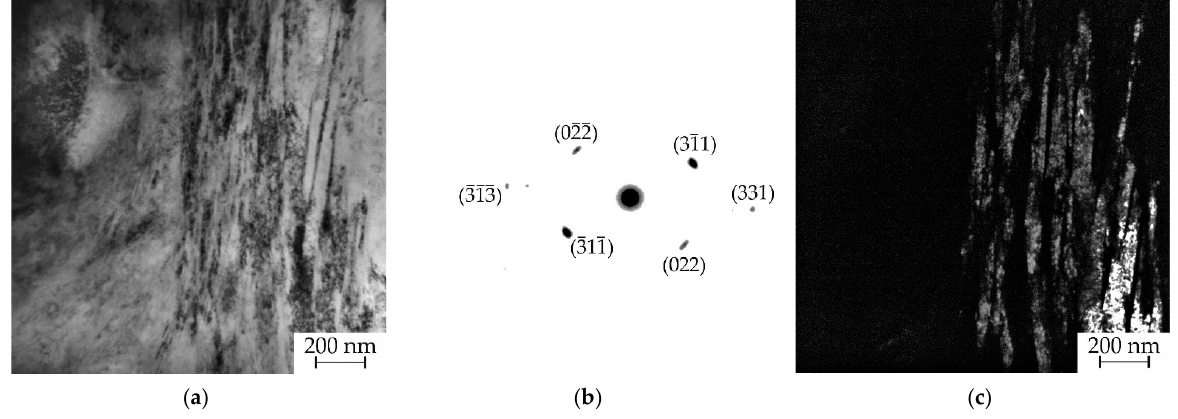
Figure 2. The bright-field microstructure image (TEM) of samples after abc-pressing at 1.84 ( a ); the microdiffraction pattern from the central zone of right grain ( b ); the dark-field image, (cid:4666) 3 (cid:3364) 11 (cid:3364)(cid:4667) R phase reflection ( c ).